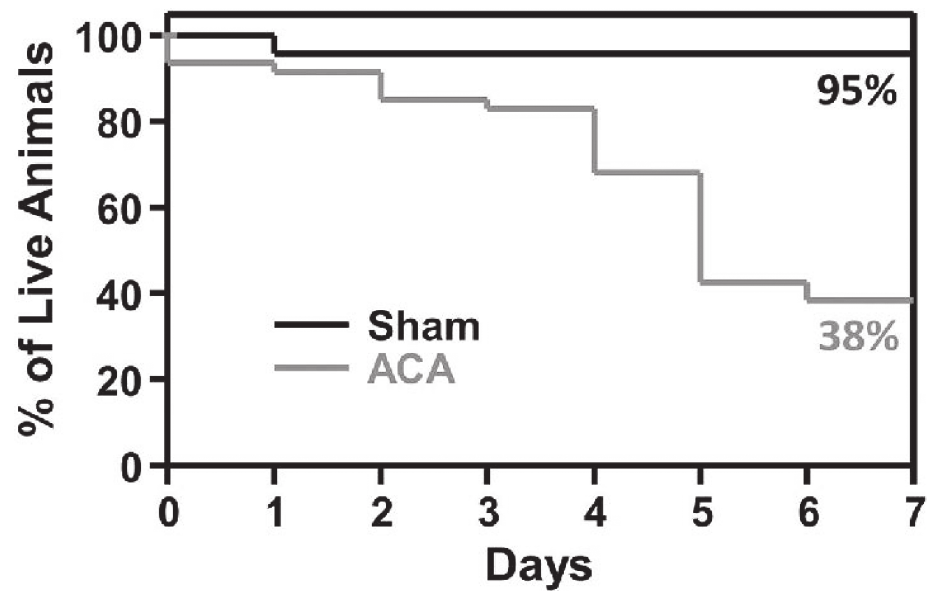
Fig 1. Survival rate following Sham or ACA procedure. Kaplan-Meier curve of animal survival for seven days following Sham or ACA procedures. At day seven, the survival of Sham animals was 95% and 38% for ACA rats (Sham n = 22 and ACA n =